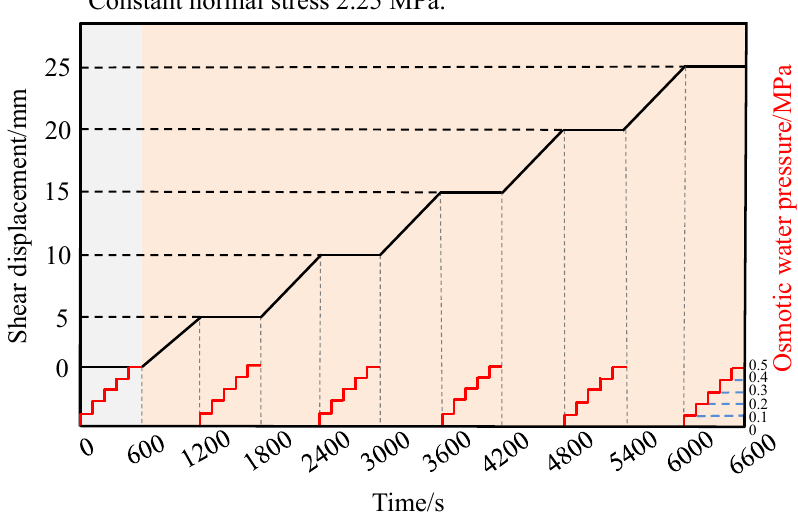
Figure 3. Schematic diagram of the shear seepage test system.